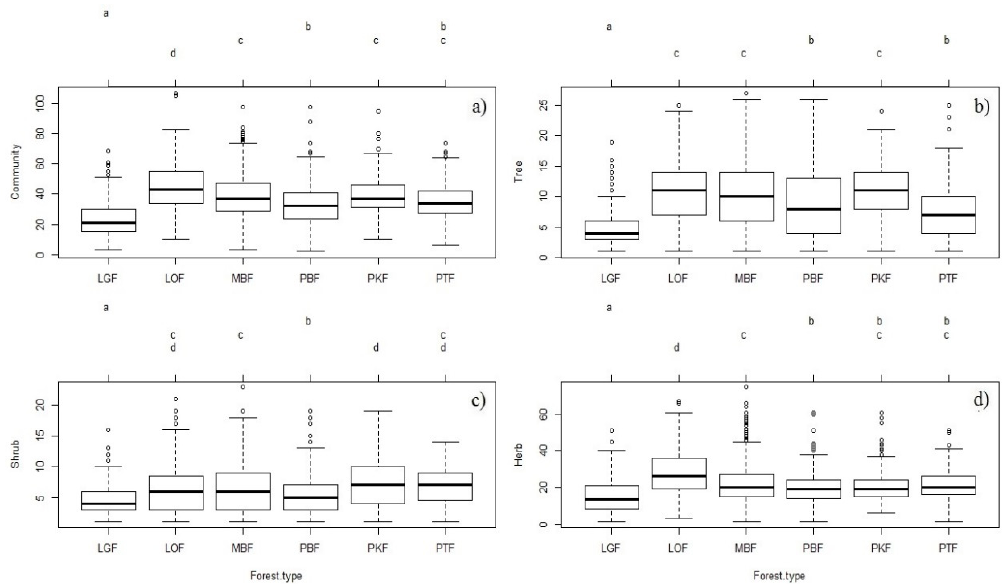
Figure 4. Mean richness of function groups in different forest types. ( a ) total richness, ( b ) tree richness, ( c ) shrub richness, and ( d ) herb richness. The same letters indicate not significant differences between forest types.